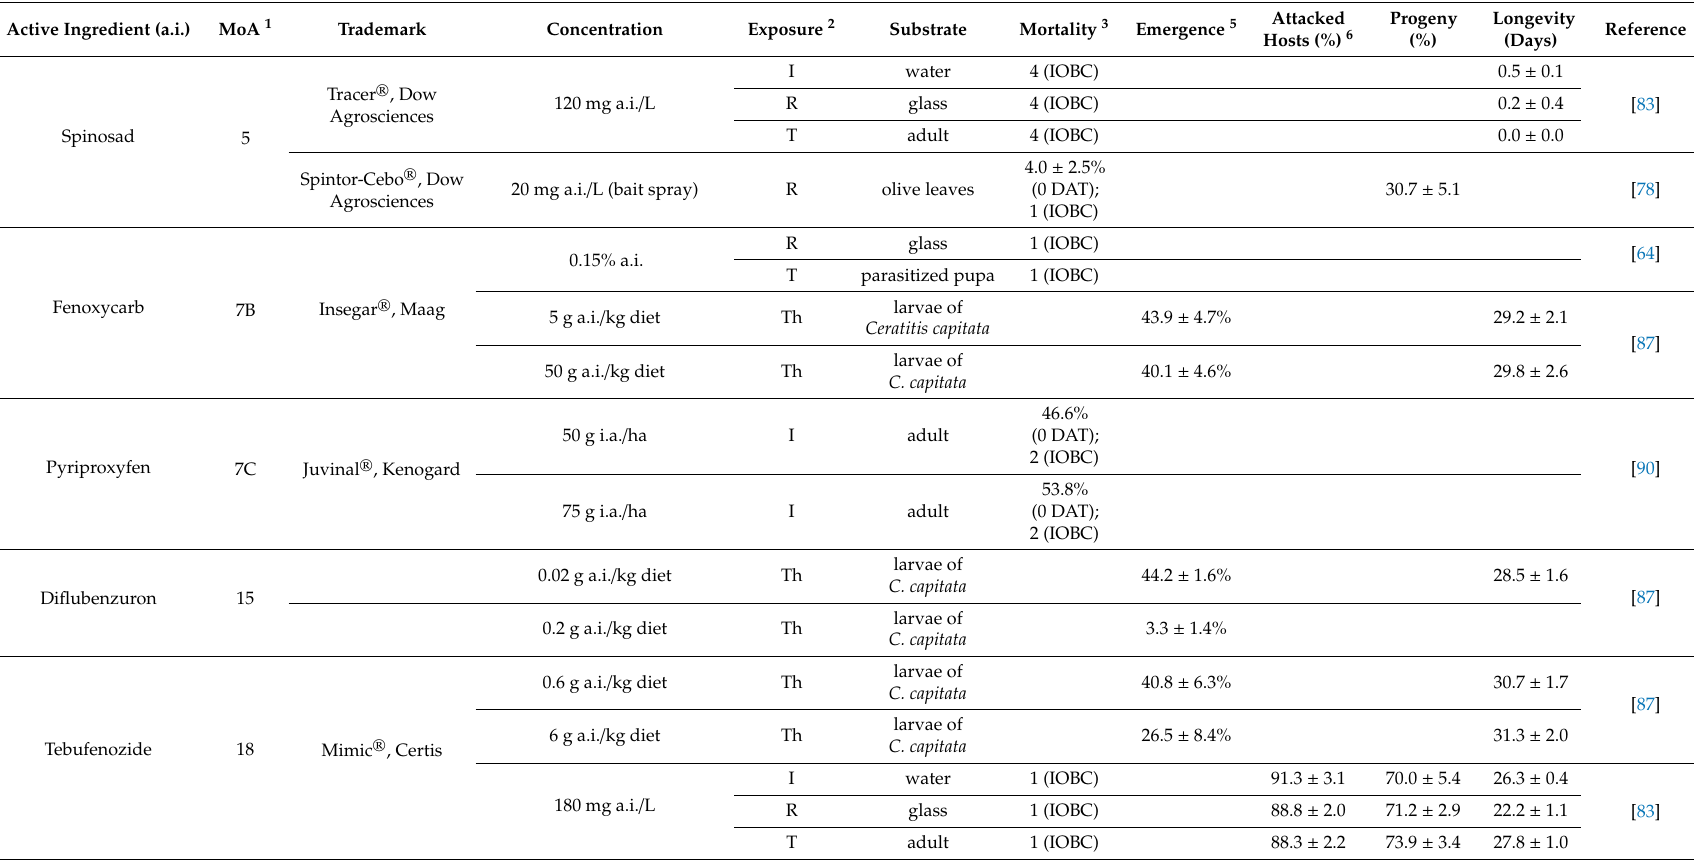
Active Ingredient